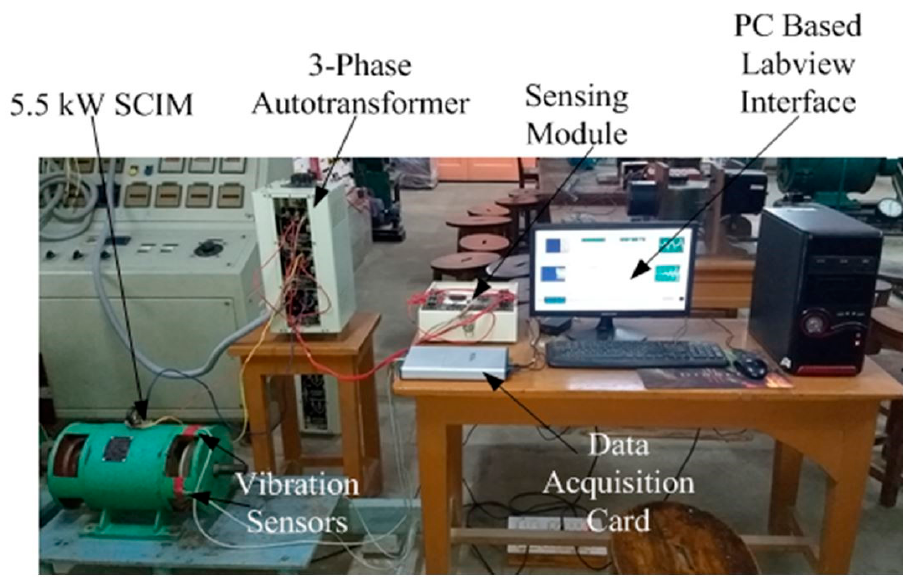
Figure 11. Experimental setup for the validation of the proposed fault detection scheme.